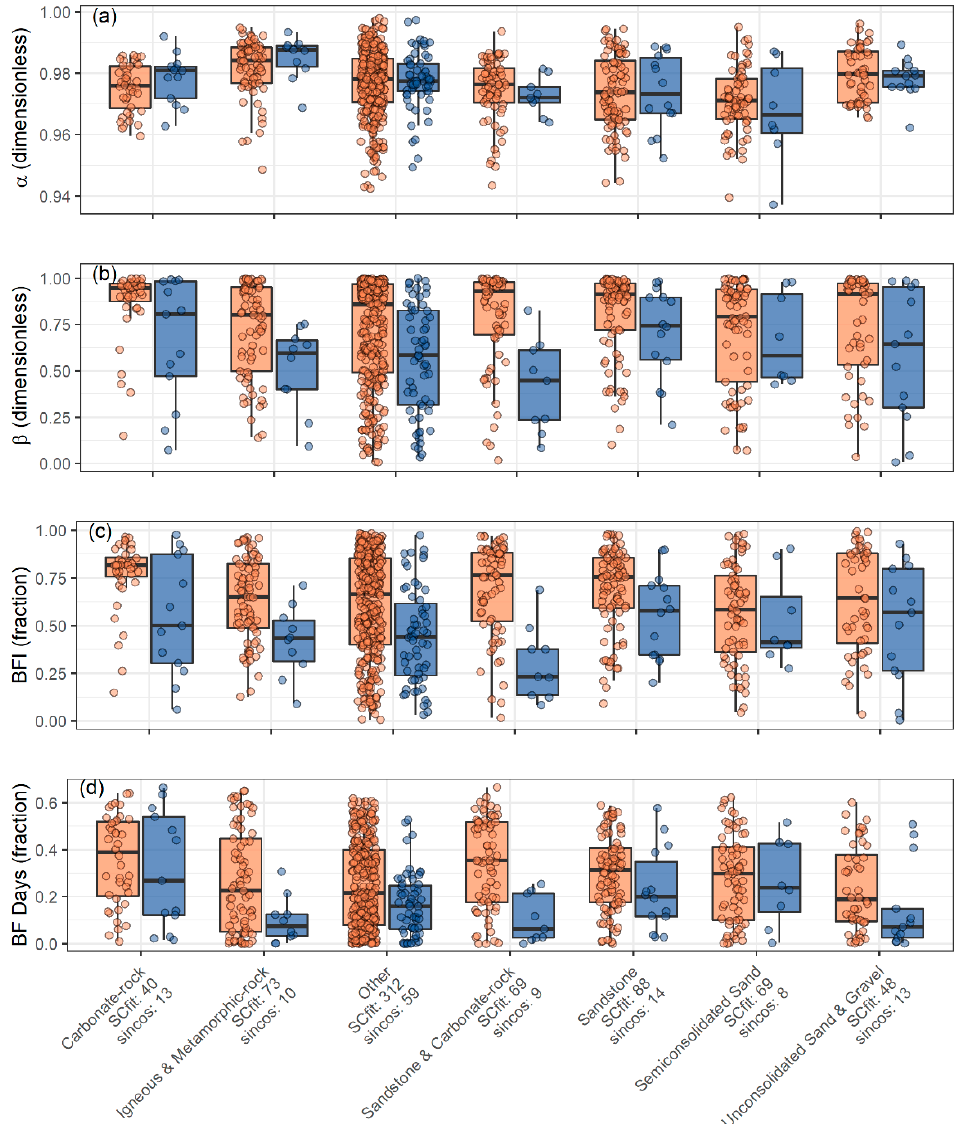
Figure 5. Distributions of ( a ) α , ( b ) β , ( c ) BFI, and ( d ) BF days for each aquifer type [57]. The orange box plots represent SCfit model types and the blue box plots represent sin-cos model types. The number of samples are listed by model type in the x-axis.